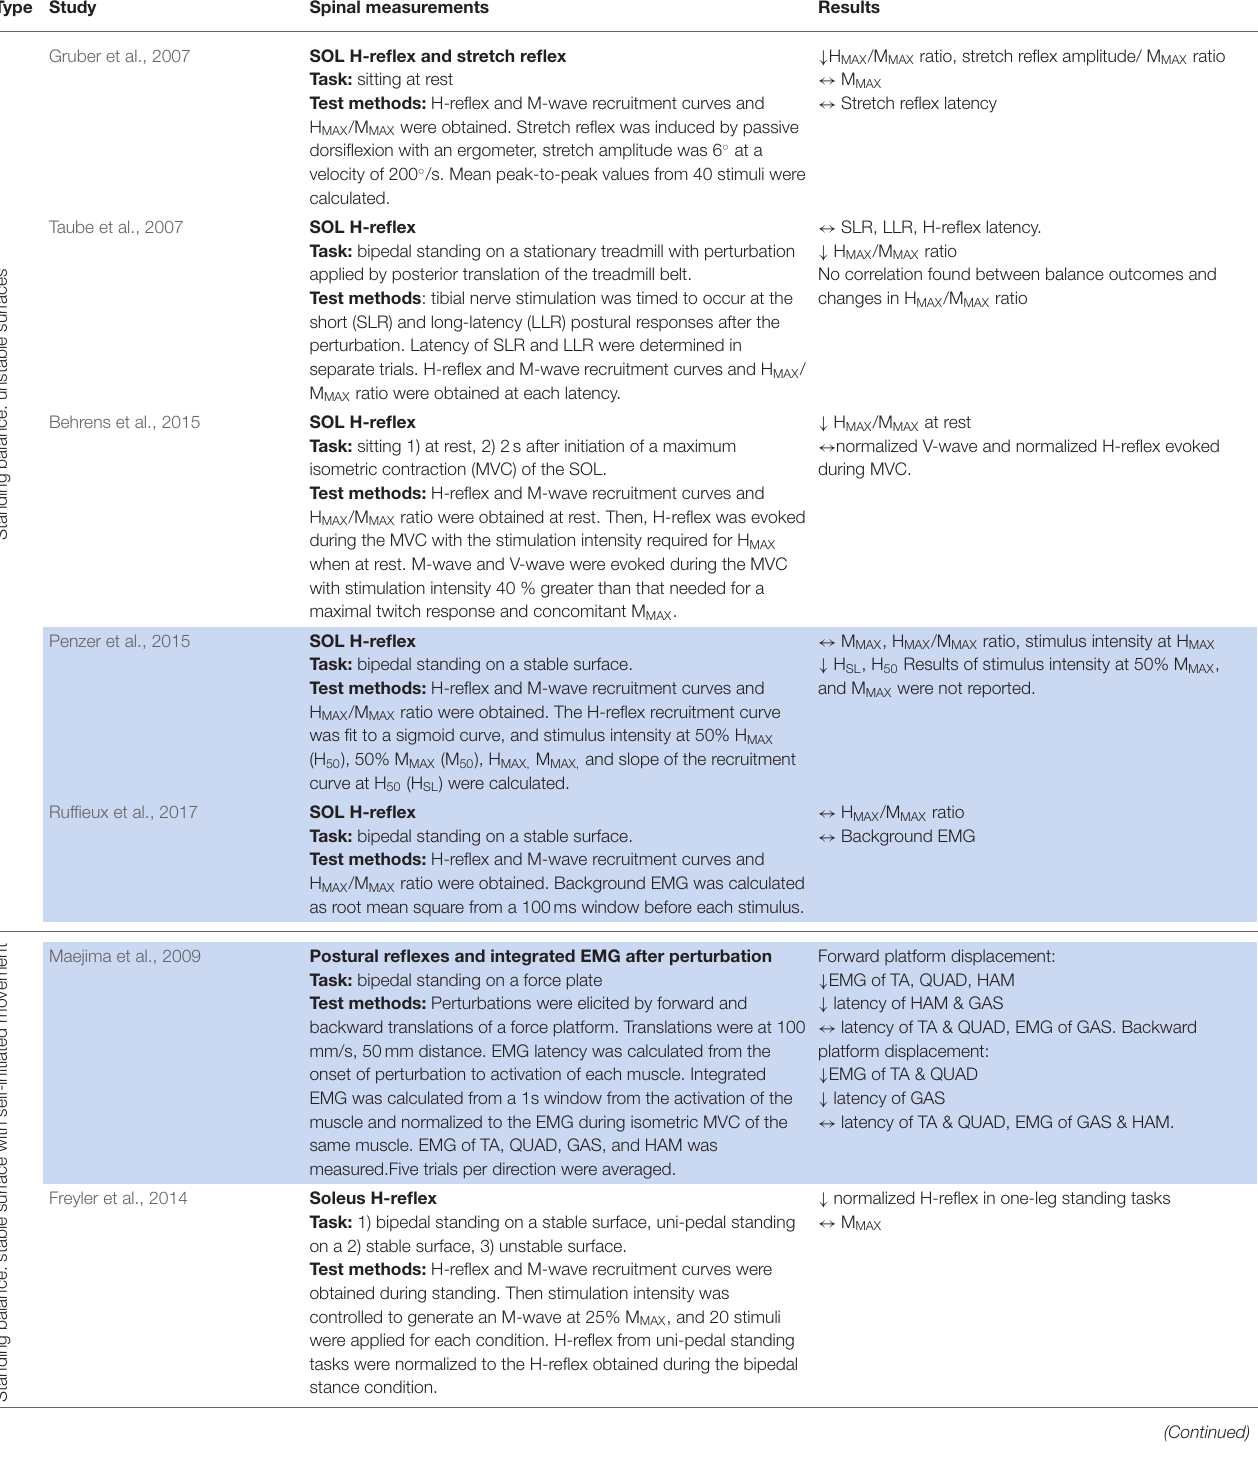
TABLE 3 | Spinal excitability - measurements and results. Type